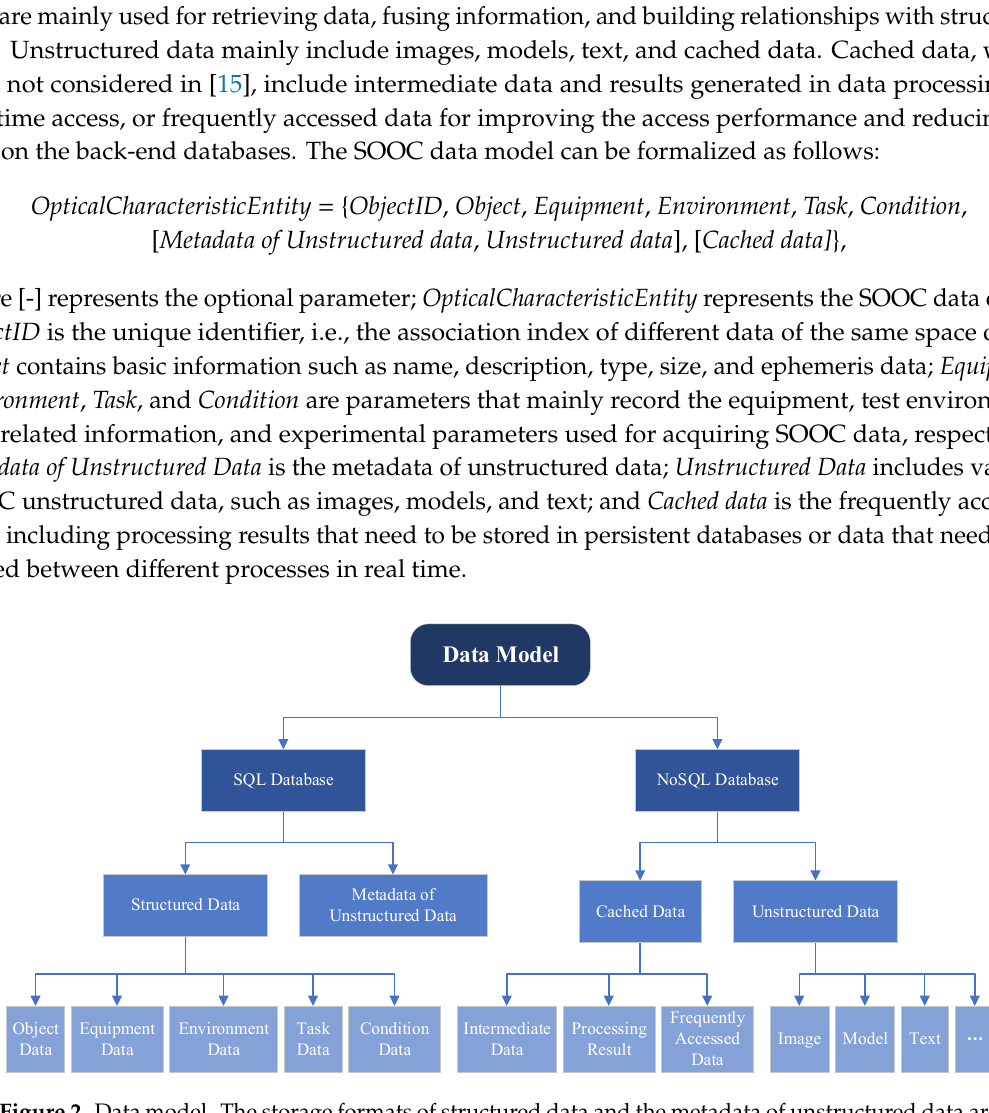
Figure 2. Data model. The storage formats of structured data and the metadata of unstructured data are predefined and fixed. The cached data changes according to requirements and the format is